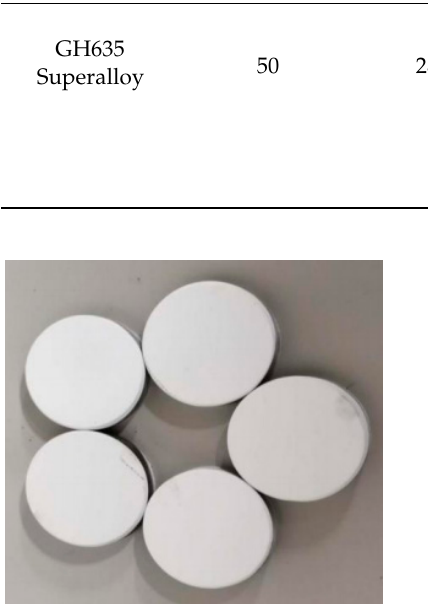
Table 1. Spraying parameters of the top coating deposited and bond coating by atmospheric plasma